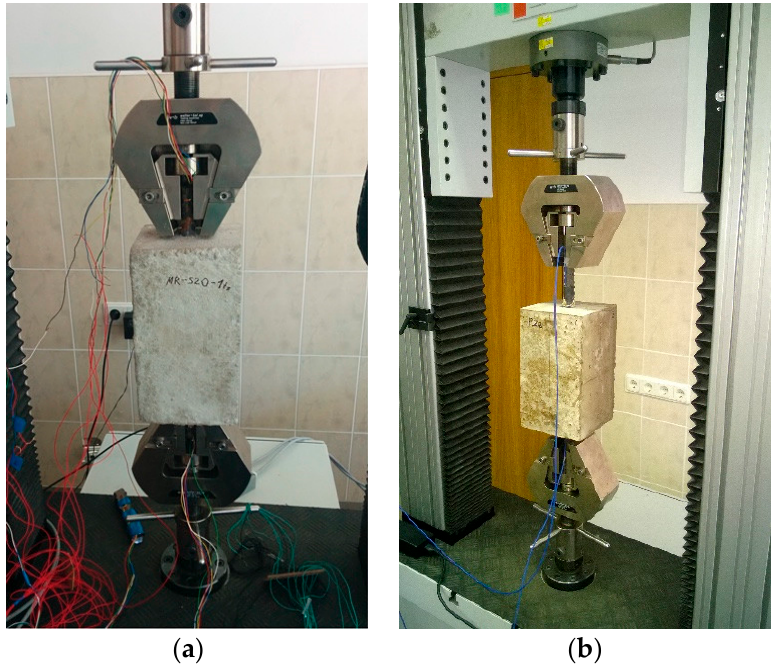
Figure 3. Experimental setups of: ( a ) Tensor strain gauge test and ( b ) FBG sensor test.